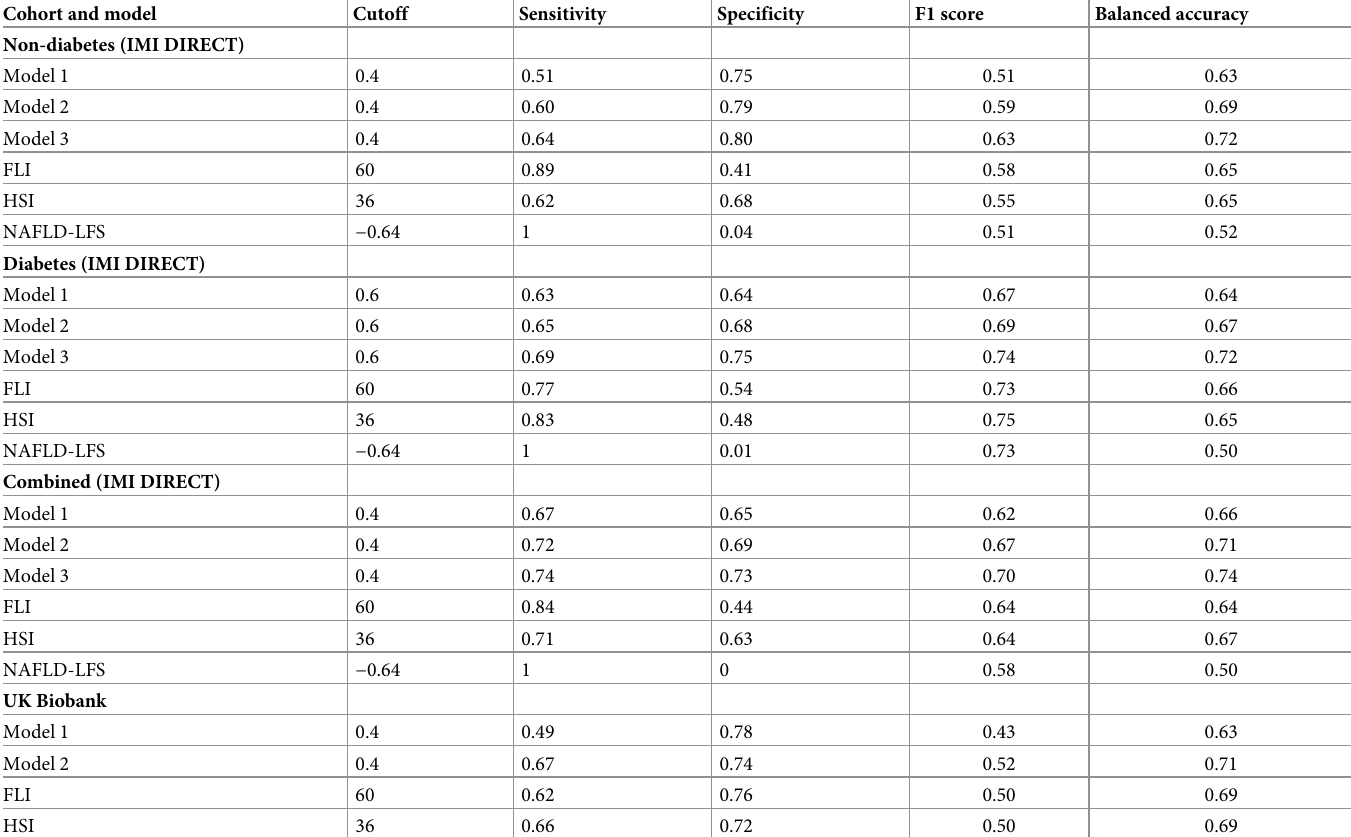
Table 2. An overview of the prediction models’ performance metrics for clinical models 1–3, fatty liver index (FLI), hepatic steatosis index (HIS), and non-alcoholic fatty liver disease liver fat score (NAFLD-LFS) in the IMI DIRECT and UK Biobank